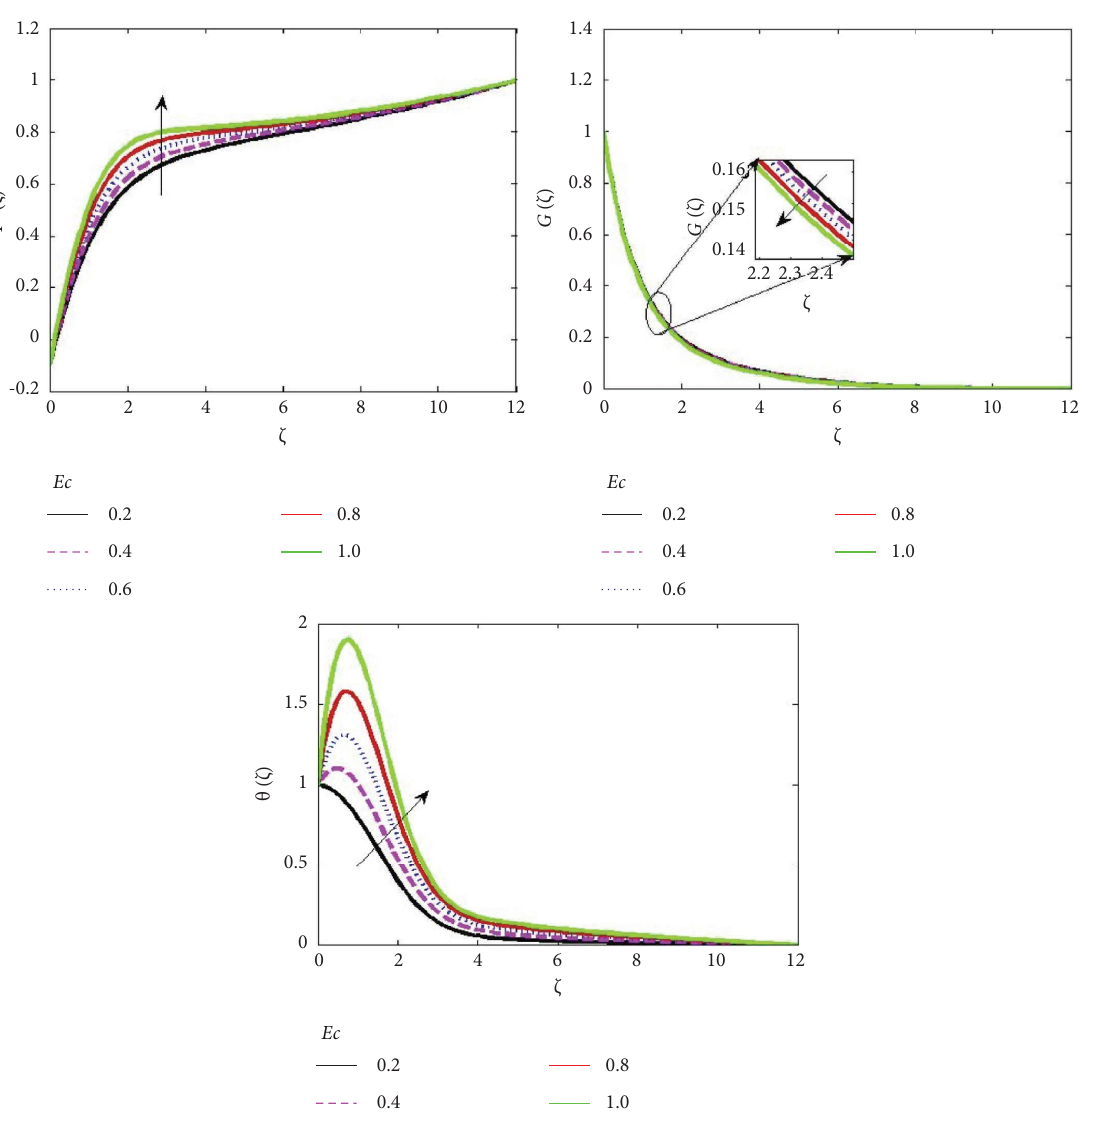
Figure 12: Efect of the Eckert number on the velocity, azimuthal velocity, and temperature